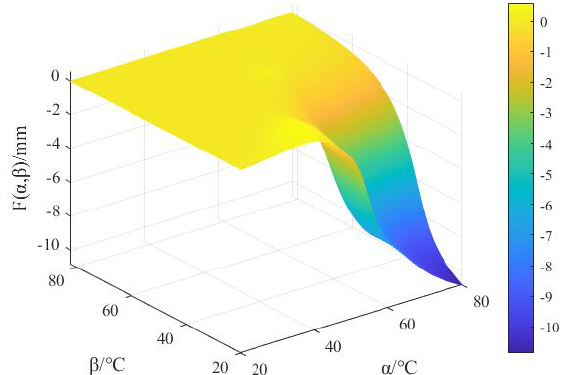
Figure 13. Preisach plane.